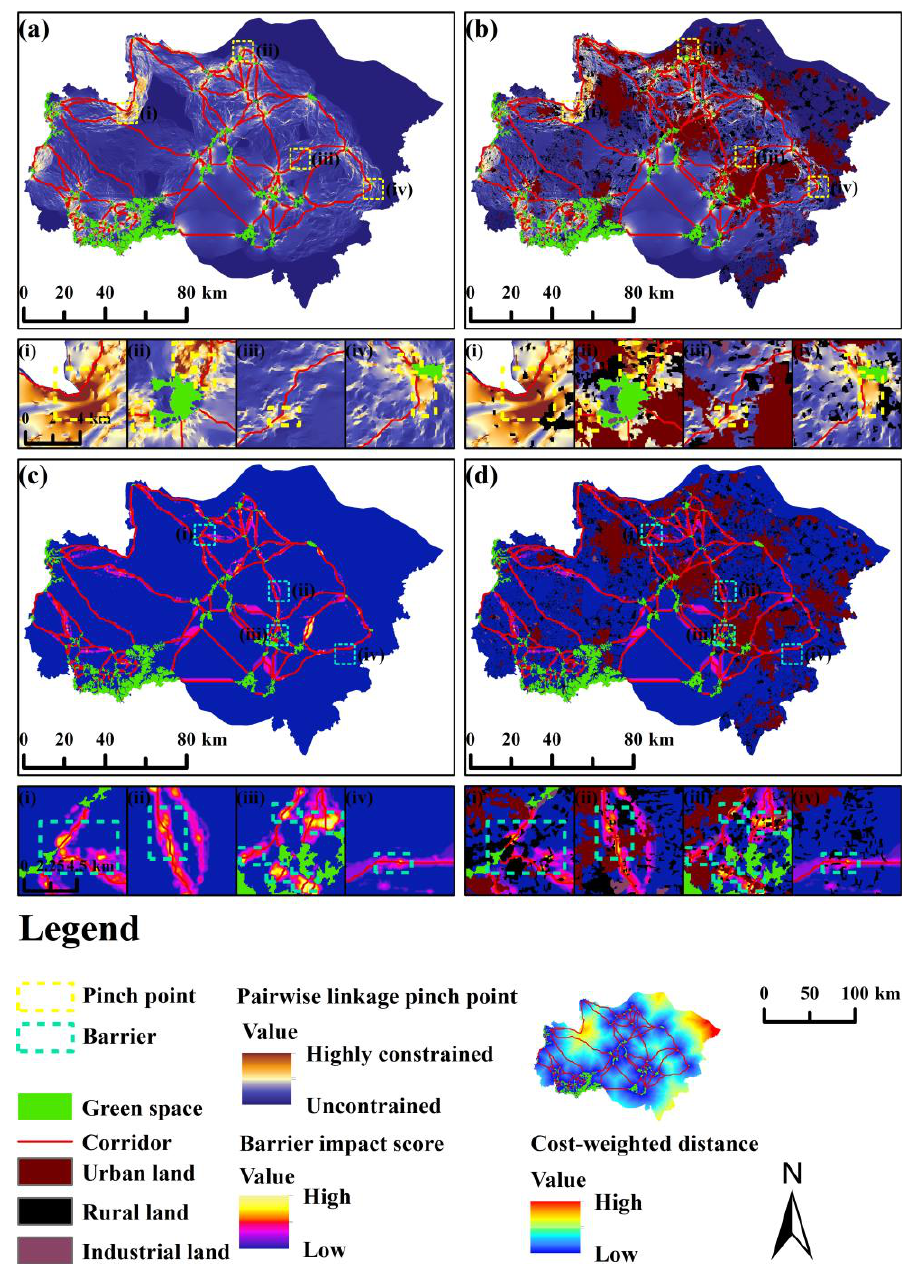
Figure 3. Maps of pinch point ( a ) and barrier ( c ) analysis results based on circuit theory. To visualize the encroachments caused by built land, layers of urban, rural, and industrial land were added to the maps of ( b , d ), respectively based on maps of ( a , c ). (i), (ii), (iii) and (iv) show the details.